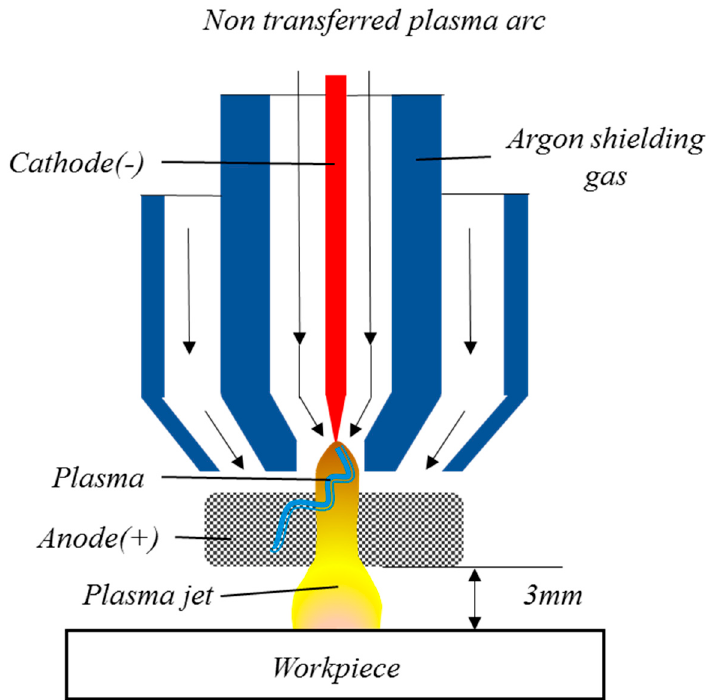
Figure 2. Design of a non-transfer plasma torch.